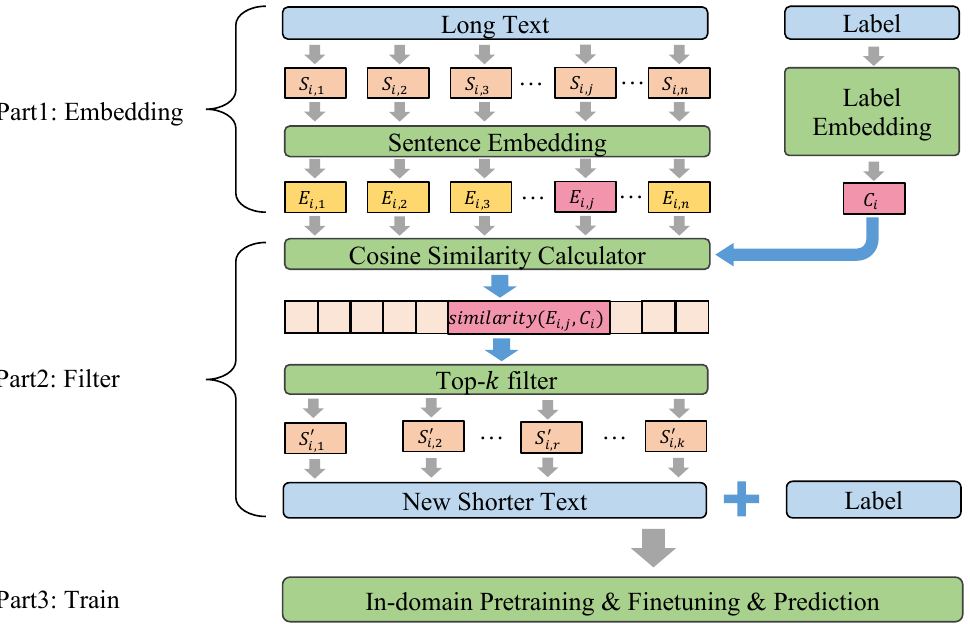
Figure 1. The whole framework of LTTA-LE. In this figure, S i , j , i ∈ [ 1, m ] , j ∈ [ 1, n ]